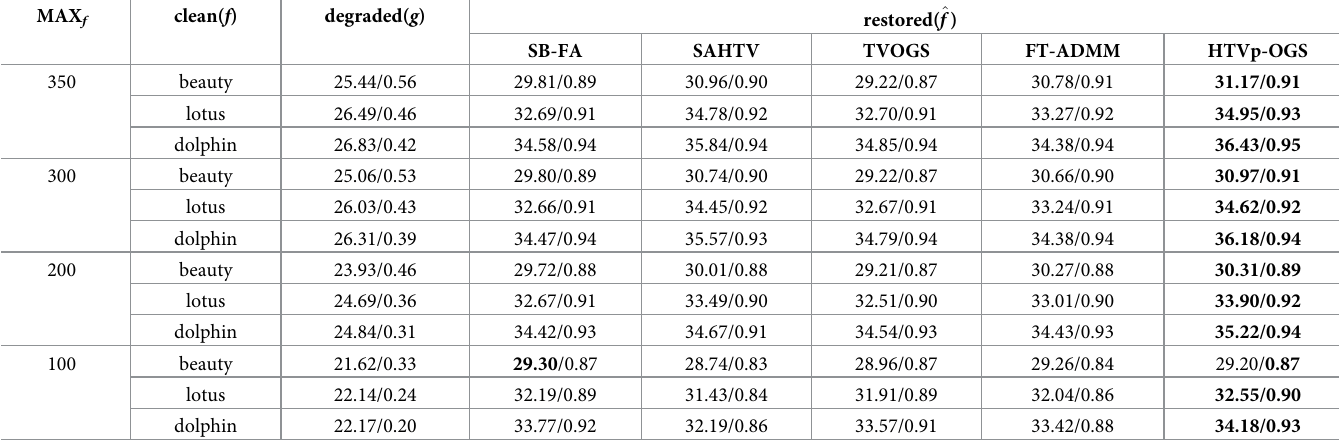
Table 4. The PSNR and SSIM values for the Poisson image restoration by different methods in the case of the ground truth blur.